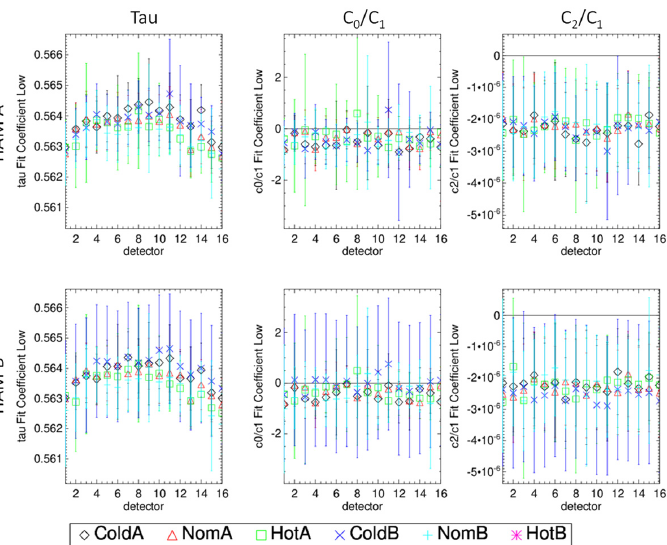
Figure 14. Band M1 low gain fit coefficients for all detectors ( x -axis) and TVAC/electronics configu- rations (colors and symbols). The columns are tau, c 0 𝑐 0 nominal, and hot plateaus and electronics sides A and B are shown